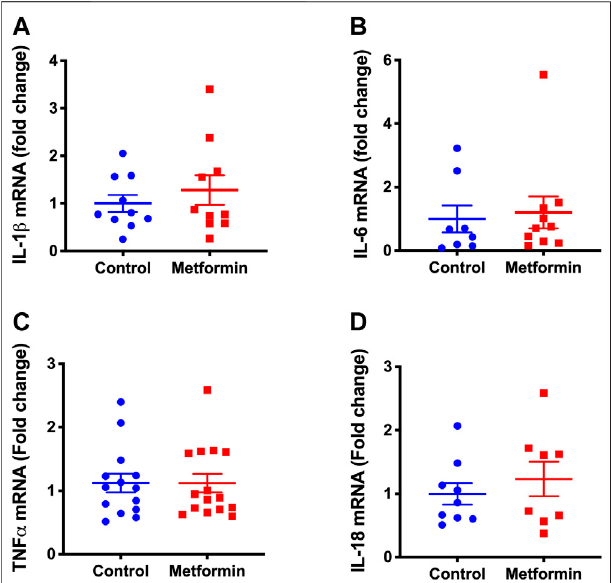
FIGURE 5 | Transcription of lung cytokines in metformin and control groups after treatments. (A) Interleukin-1 beta (IL-1 β ), (B) Interleukin-6 (IL-6), (C) Tumor necrosis factor alpha (TNF- α ), (D) Interleukin-18 (IL-18) mRNA levels in lung tissue of metformin and control groups after treatments. The results were expressed as relative fold changes to controls. Not detectable: IL-10, IL-17, IL-5, and IL-13